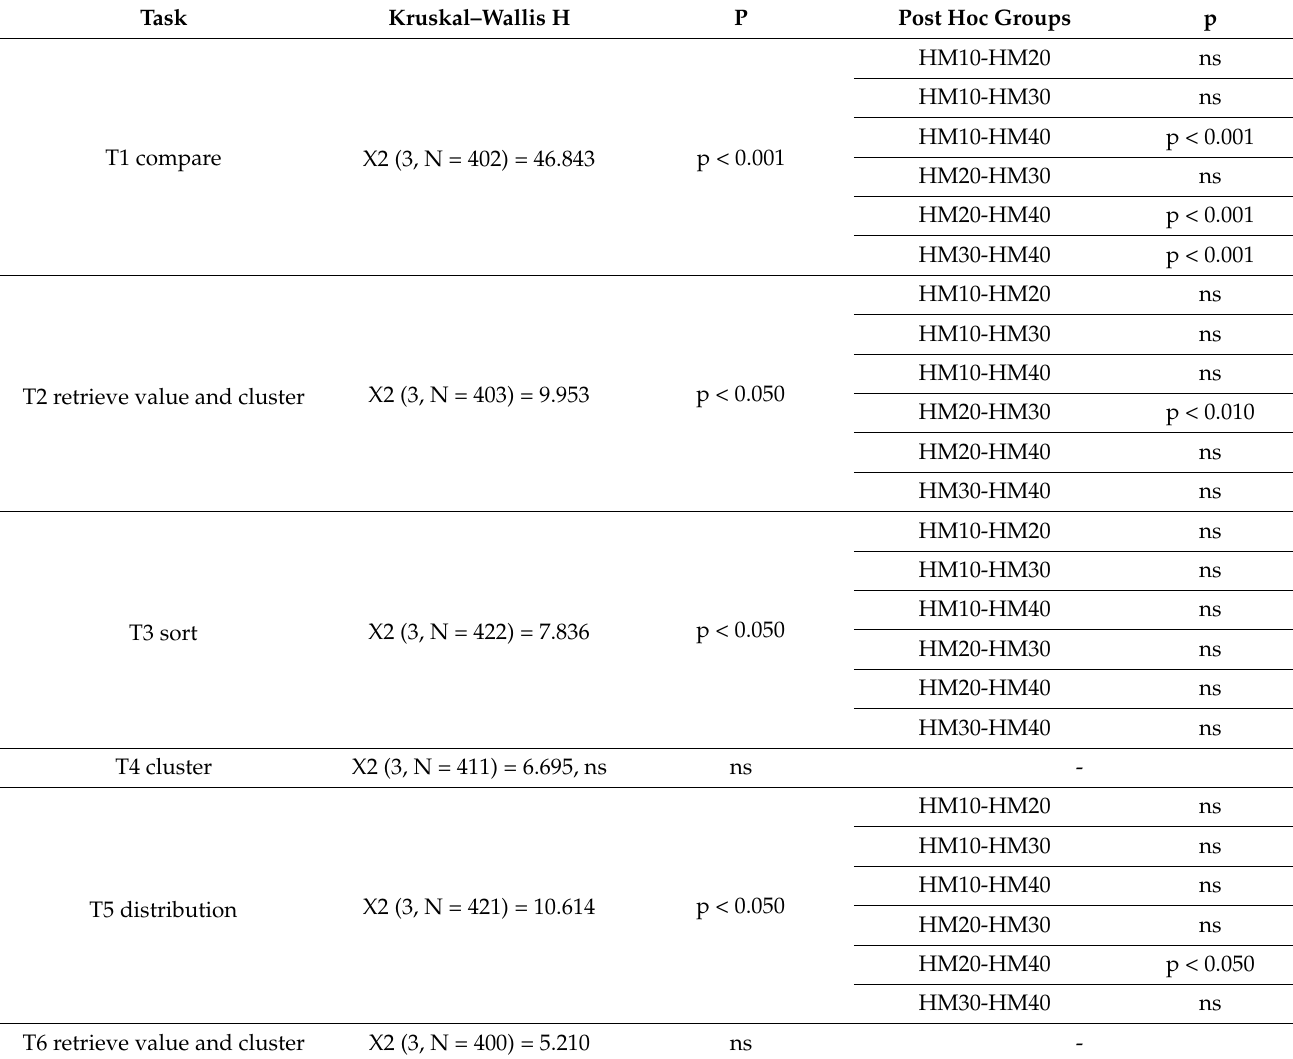
Table 6. Inferential statistics between participants using the four tested heat maps.